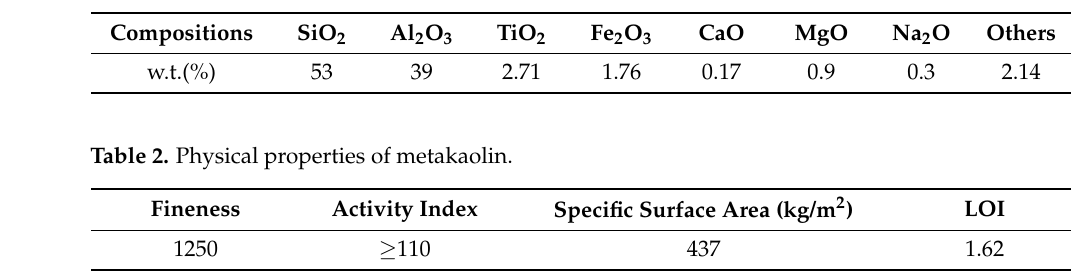
Table 1. Compositions of metakaolin.